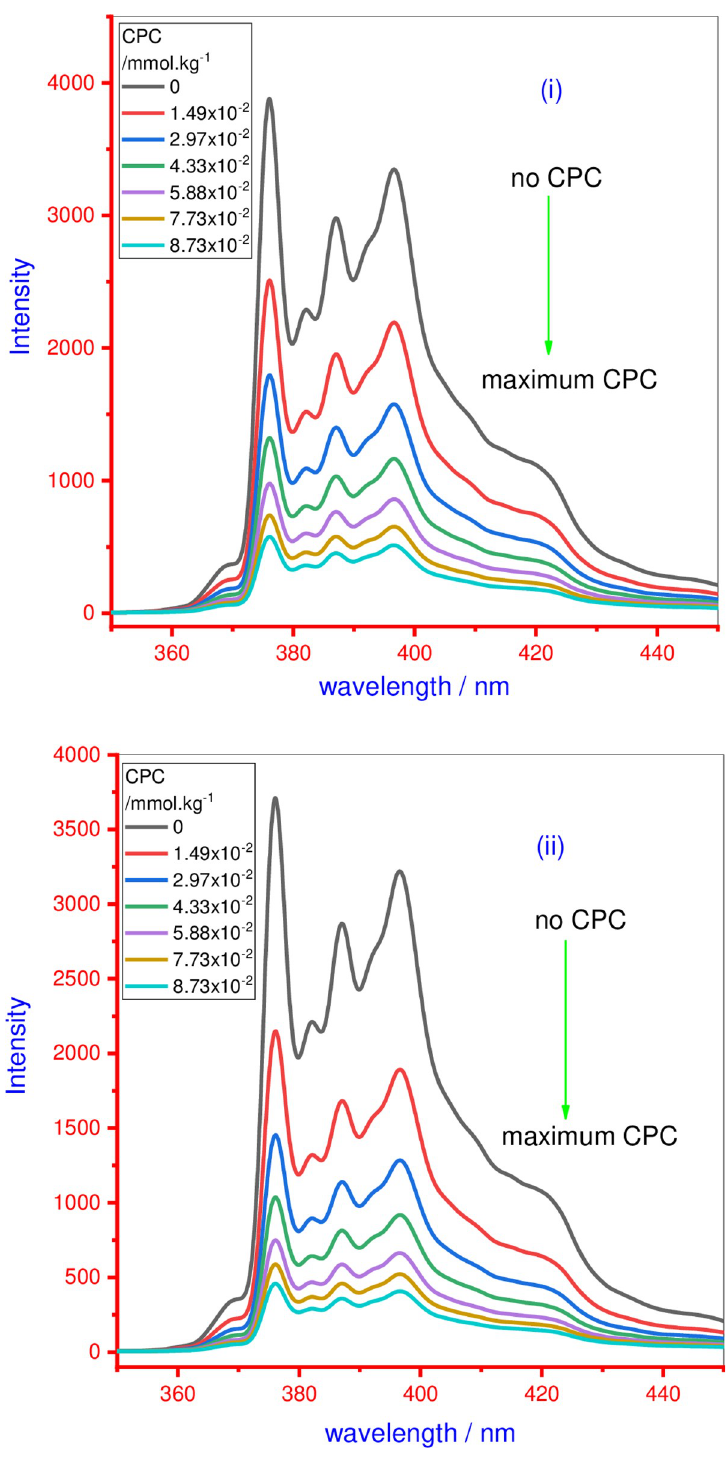
Fig 5. The 10 − 3 mmol.kg -1 pyrene (PY) solution fluorescence spectra of (i) individual 14-E2-14, and (ii) 14-E2-14 (0.8) +AMT (0.2) micellar mixed system at diverse quencher concentrations in presence of 0.050 mol.kg -1 NaCl.